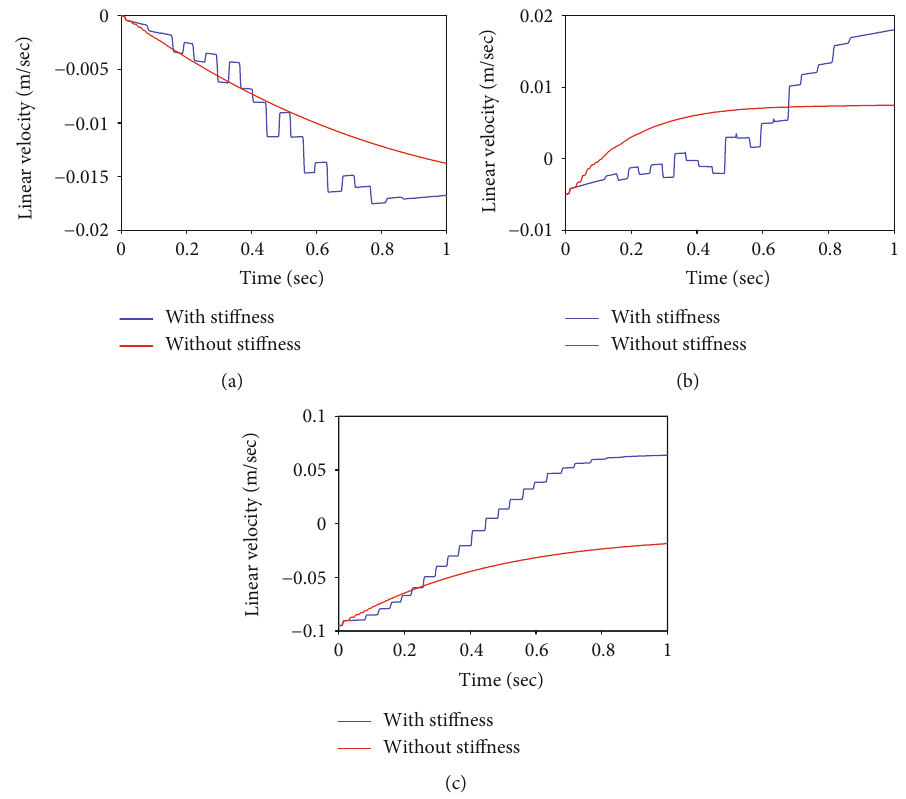
Figure 16: Linear velocity of the point O